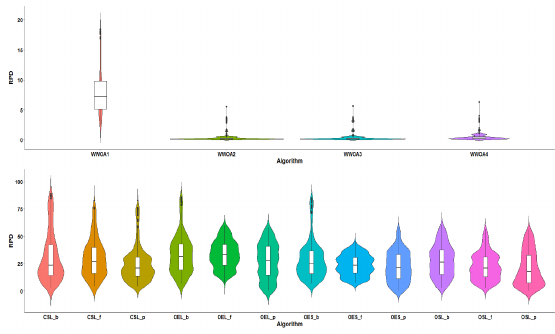
Fig. 4. Boxplots of the RPD distribution for 12 heuristics and 4 WWO